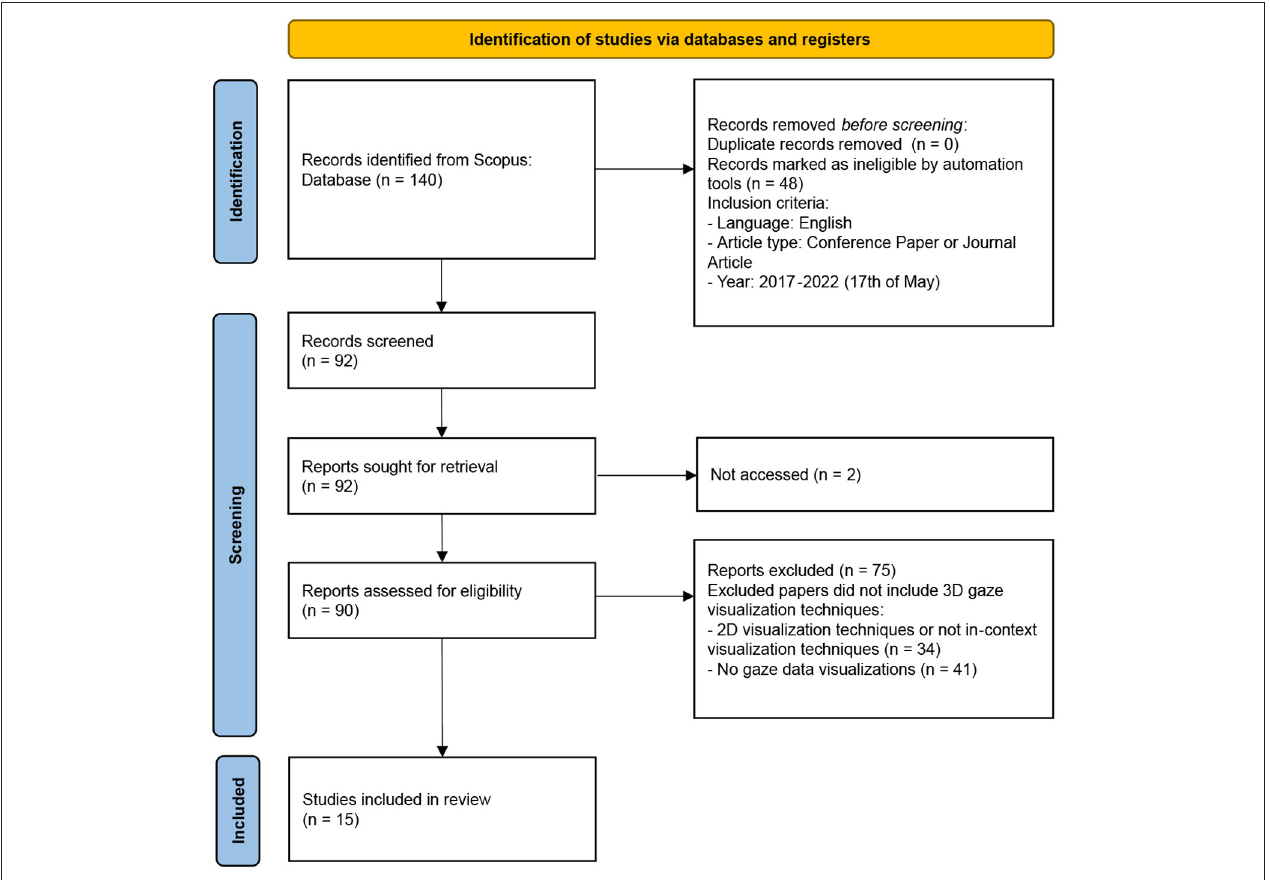
FIGURE 3 | PRISMA 2020 flow diagram for systematic reviews (Page et al.,